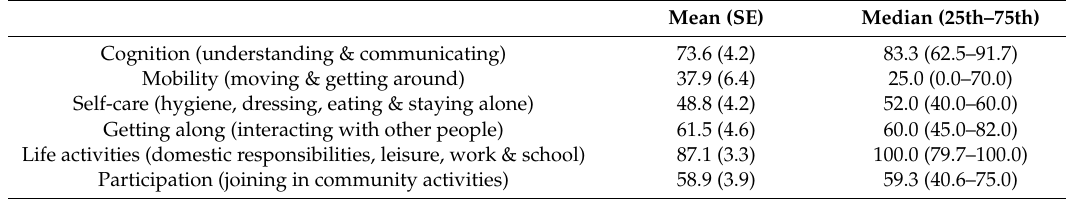
Table 4. WHODAS II value for adult patients with Cri du Chat syndrome.